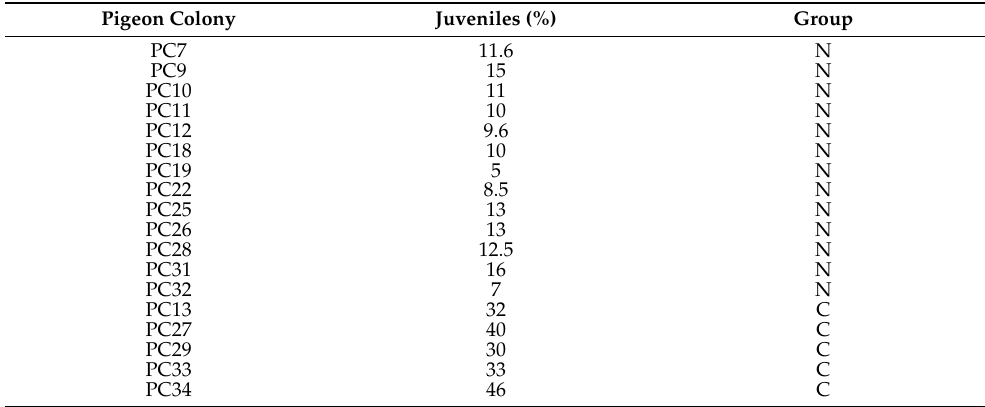
Table 2. Proportion of juveniles at the end of the 2017 superiority study in 18 pigeon colonies. Group (N, nicarbazin; C, control).